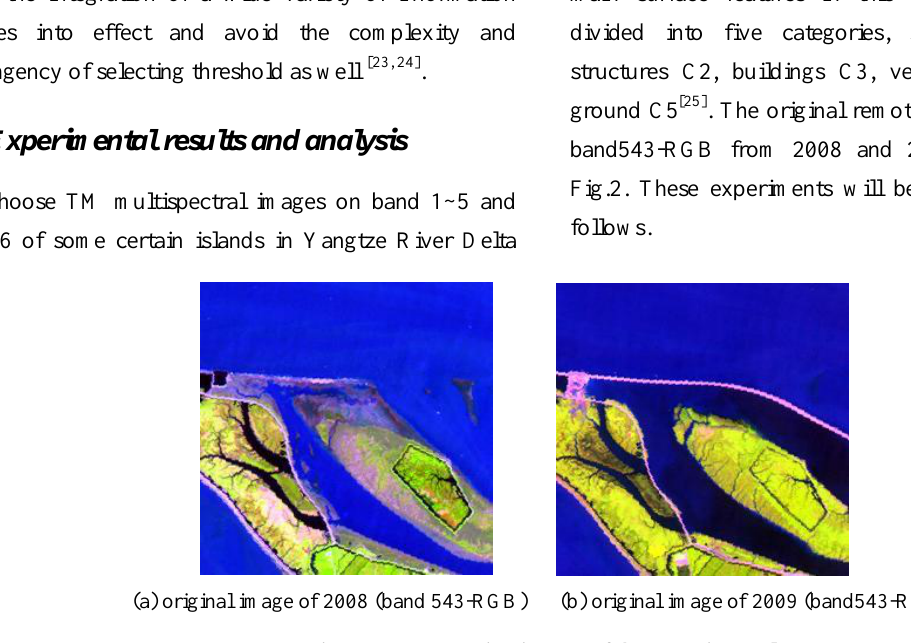
Fig. 2 Remote sensing images of the experimental area